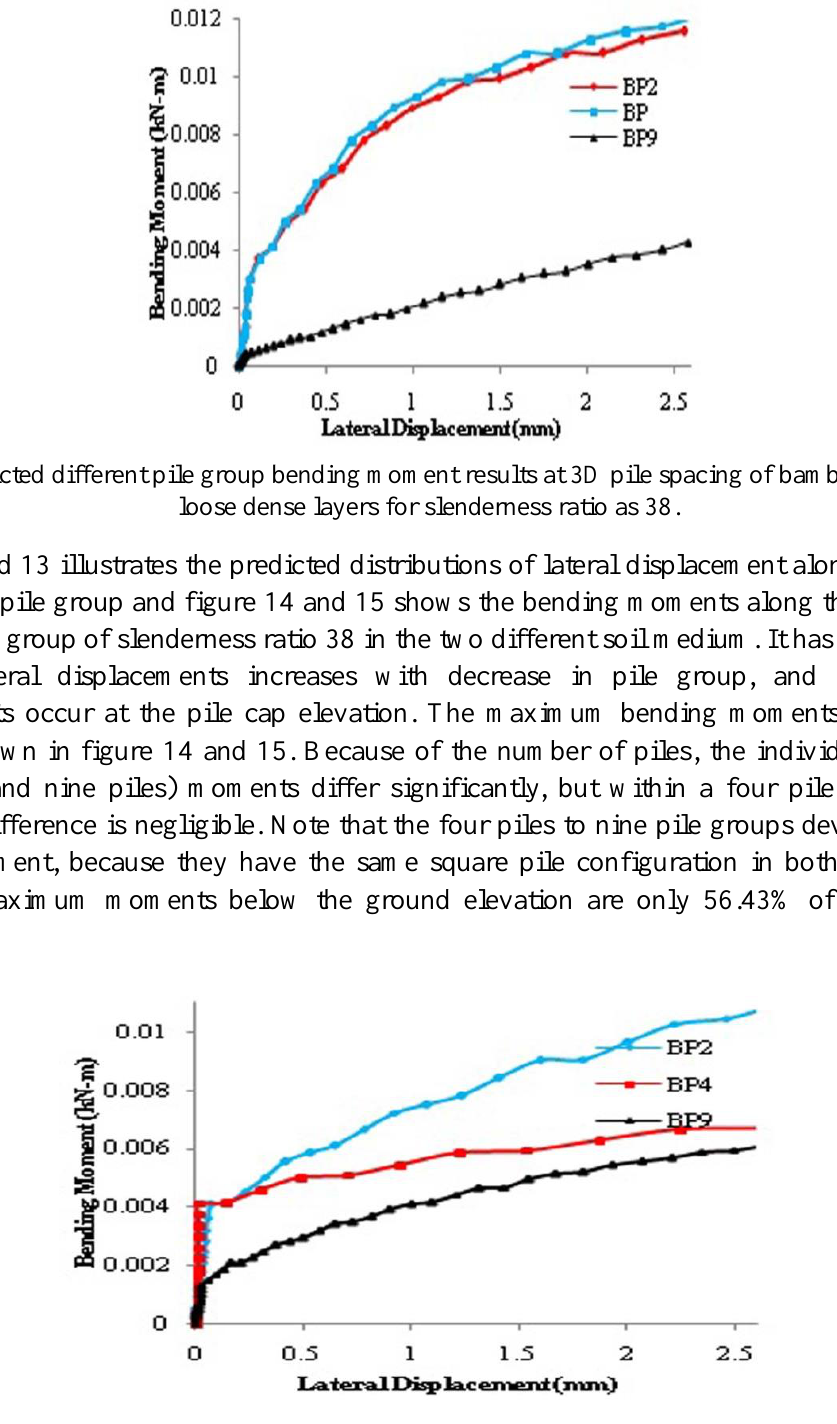
Fig. 17. Predicted different pile group bending moment results at 3D pile spacing of bamboo pipe piles in dense sand layer for slenderness ratio as